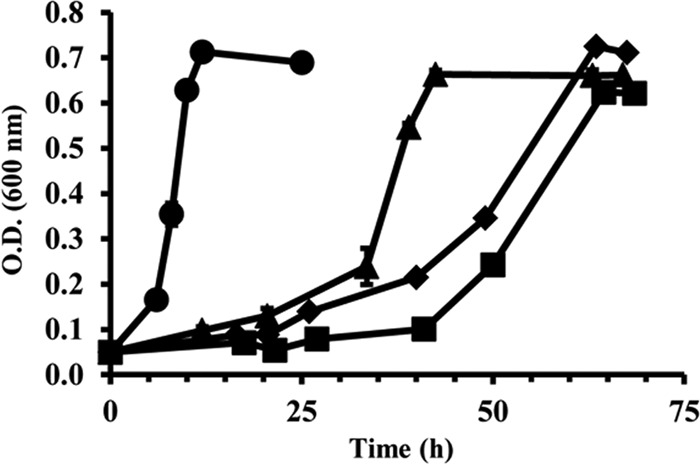
Growth of S. baltica strains in defined medium containing glucose as the single carbon source. Growth was measured as the increase in optical density at 600 nm. Circles, OS155; diamonds, OS185; triangles, OS195; squares, OS223. Missing error bars indicate a standard error smaller than the symbol.